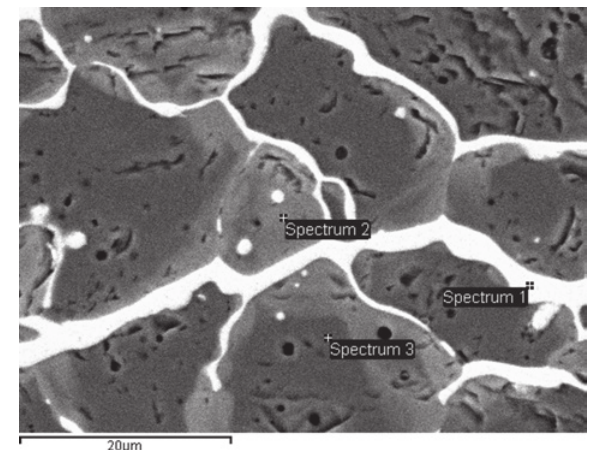
Fig. 10: SEM-BSE image of penetration zone in experiment 2 (FeMo5.2-TiC A) [22]